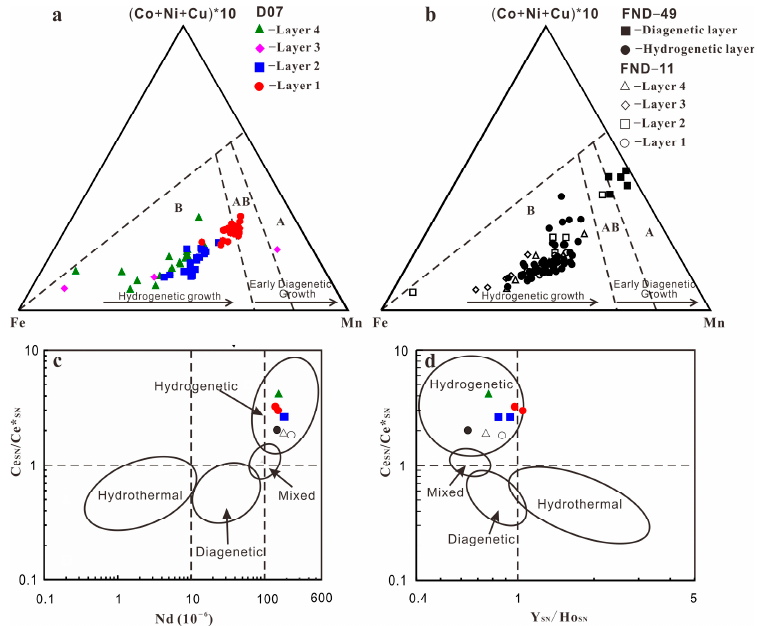
Figure 7. ( a , b ): Ternary diagram for genesis of ferromanganese deposits from Bonatti et al. (1972) [27]. Dashed black lines border the three nodule type fields. A: diagenetic nodules, AB: mixed type nodules, and B: hydrogenetic nodules and crusts. All data plotted as wt.%; ( c , d ): Discrimination diagrams based on geochemical relationships from Bau et al., 2014 [28]. All major element contents in these pictures and later pictures below are normalized data.